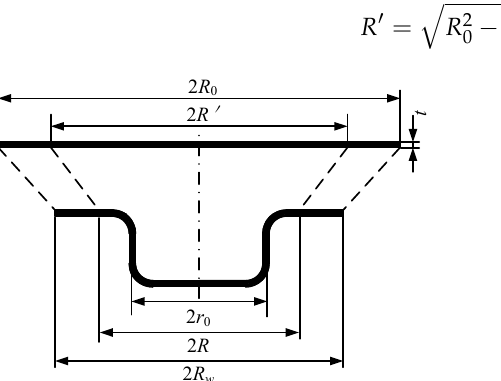
Figure 2. Schematic illustration of cylindrical blank deformation.